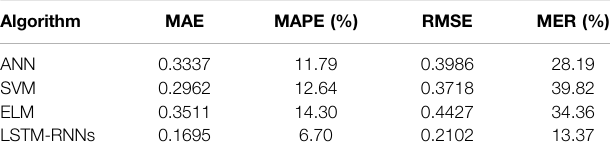
TABLE 5 | Evaluation of the calculation effect of the selected algorithm.